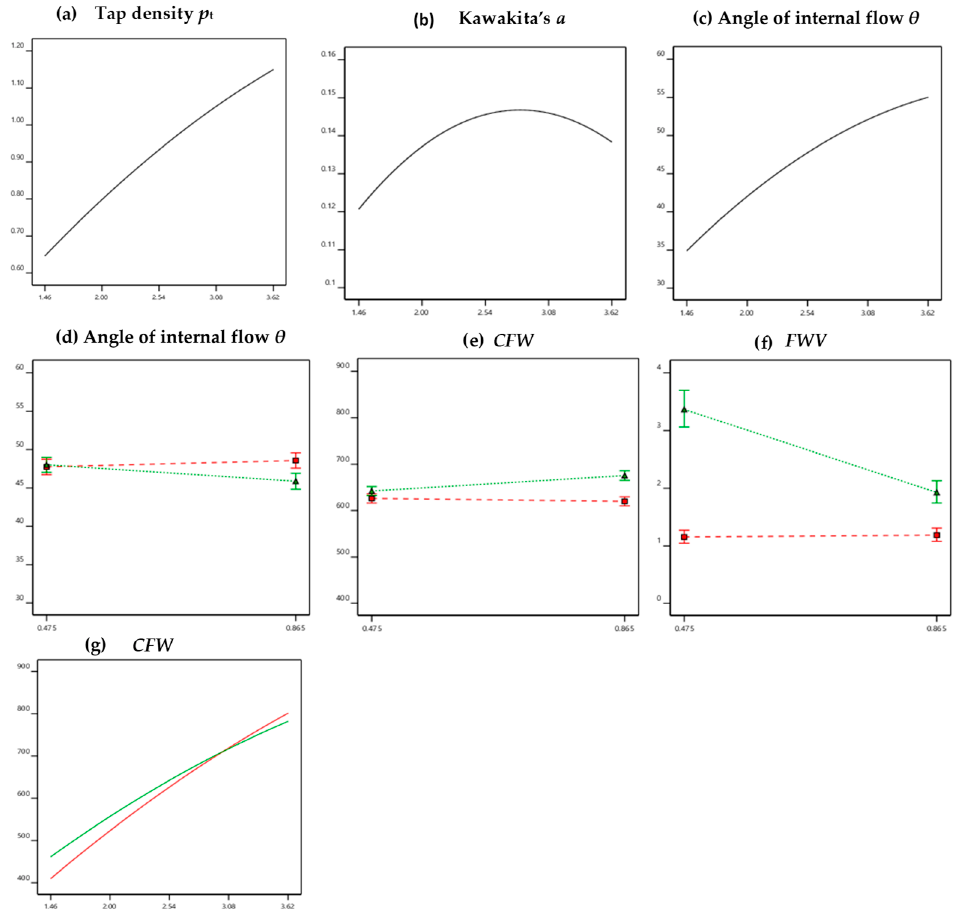
Figure 6. MLR analysis—Quadratic effects of pellet density on tap density ( a ), Kawakita’s a ( b ), and angle of internal flow ( c ). Interactions of the effects of pellet size and coating (green/solid plain, red/dotted coated) on the angle of internal flow ( d ), capsule fill weight ( e ), and fill weight variation ( f ), and interactions of the effects of pellet density and coating (green/solid plain, red/dotted coated) on capsule fill weight ( g ).